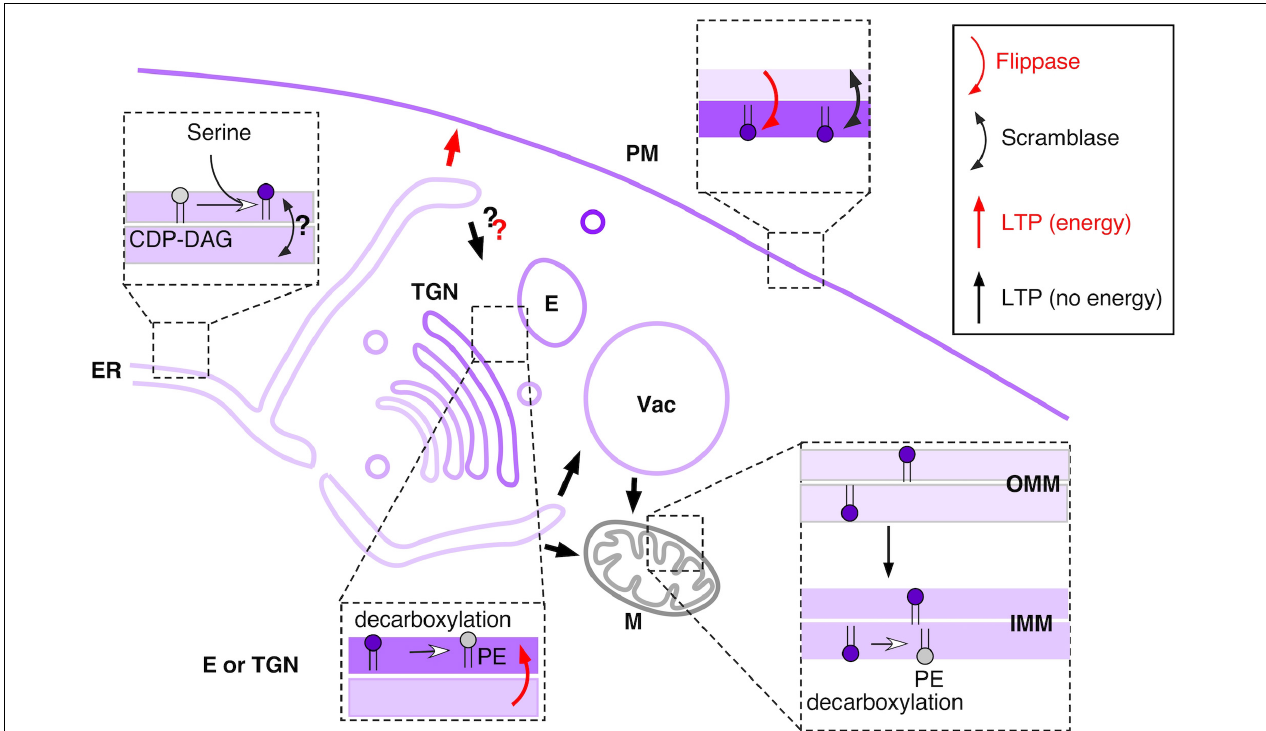
FIGURE 1 | Overview of main PS metabolic and transport pathways in budding yeast. See text for details. Shades of purple indicate approximate relative PS concentration in different membranes or leaflets. PS is represented with a purple headgroup. Red arrows indicate PS transport pathways that require energy (transport against concentration gradient), whereas black arrow indicate passive PS transport. E – endosome, IMM – inner mitochondrial membrane, M – mitochondria, OMM – outer mitochondrial membrane, TGN – trans -Golgi network, Vac – vacuole.